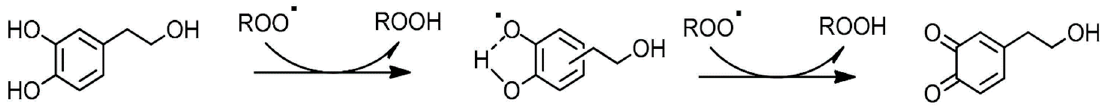
Figure 2. Mechanism of free radical scavenging exerted by hydroxytyrosol (HT).